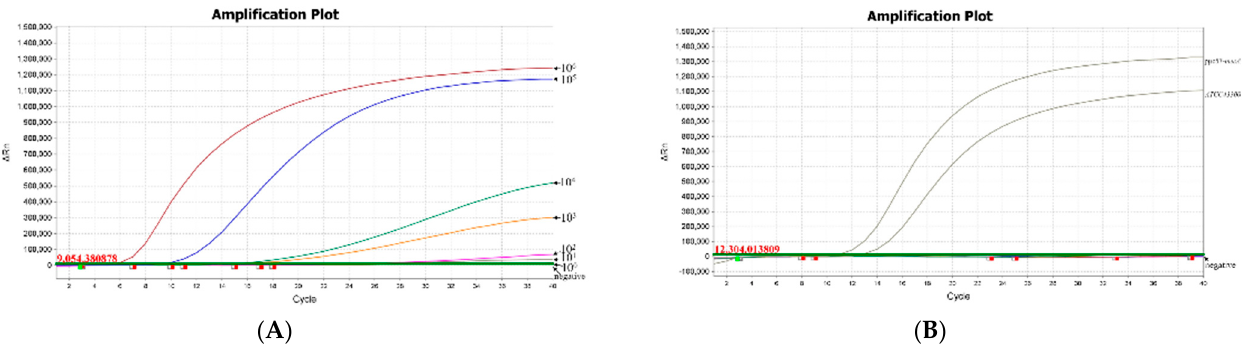
Figure 3. Sensitivity and specificity analysis of the RAA assay for mecA. ( A ) The analytical speci- ficity of the RAA assay. Amplification curves in different colors are RAA reaction readouts to which serial dilutions of positive plasmids were added. The dilutions of positive plasmids were 10 6 copies/reaction, 10 5 copies/reaction, 10 4 copies/reaction, 10 3 copies/reaction, 10 2 copies/reaction, 10 1 copies/reaction, and 1 copy/reaction. ( B ) The analytical specificity of the RAA assay. Amplifica- tion curves in different colors are RAA reaction reads with the addition of genomic DNA templates from different bacteria, including MRSA (ATCC43300), MSSA, E. faecalis , S. agalactiae , E. coli , C. jejuni